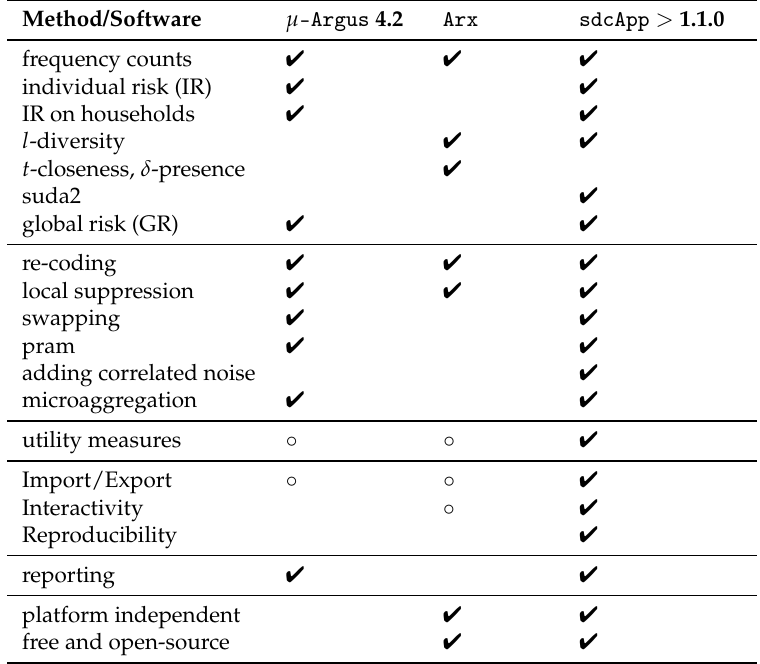
Table 1. List of methods that can be accessed via a GUI. Circles indicate only limited potentiality/support.